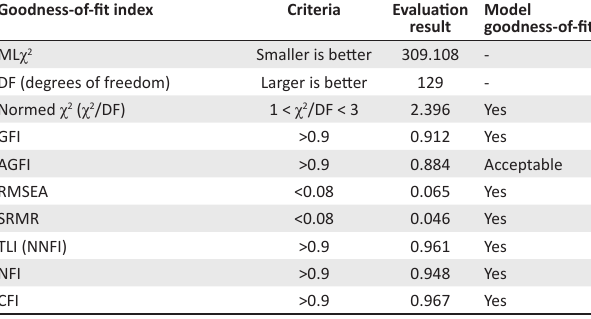
TABLE 3: Evaluation indices for the overall model goodness-of-fit. Goodness-of-fit index